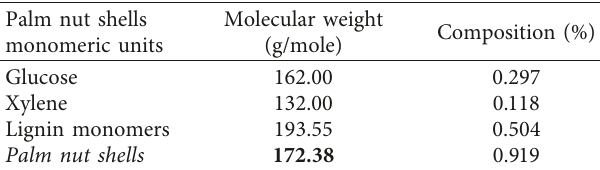
Table 2: Palm nut shells molecular